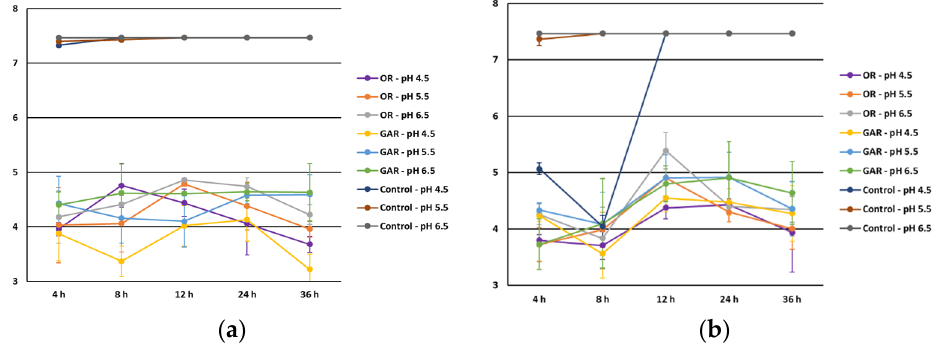
Figure 4. Influence of pH level on the antimicrobial effect of oregano (OR) and garlic (GAR) essential oils against Salmonella spp. ( a ) and Listeria monocytogenes ( b ).